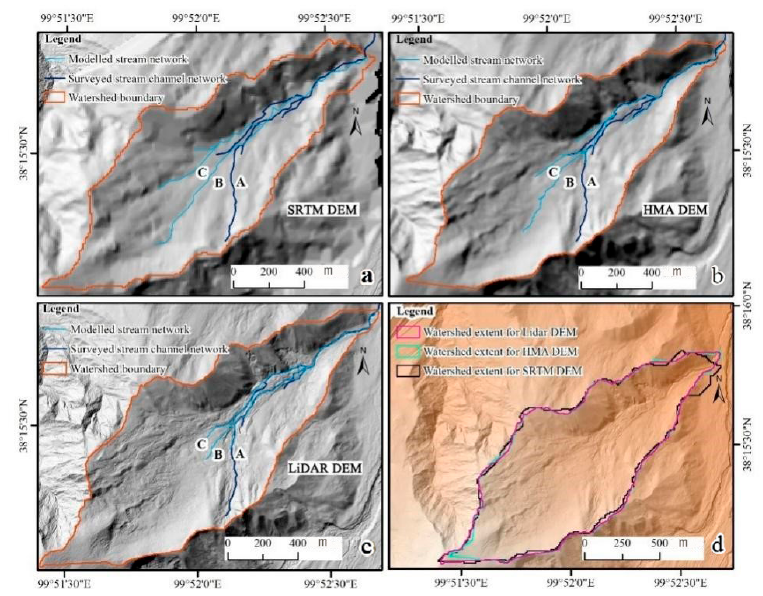
Figure 4. Stream network and watershed boundary modeled using ( a ) the SRTM DEM resampled with a resolution of 10 m, ( b ) 8 m HMA DEM derived from a high–resolution stereo pair image, ( c ) the LiDAR DEM with a resolution of 1 m, ( d ) watershed extents for the LiDAR DEM (red), HMA DEM, interpolated SRTM DEM of 10 m (black).